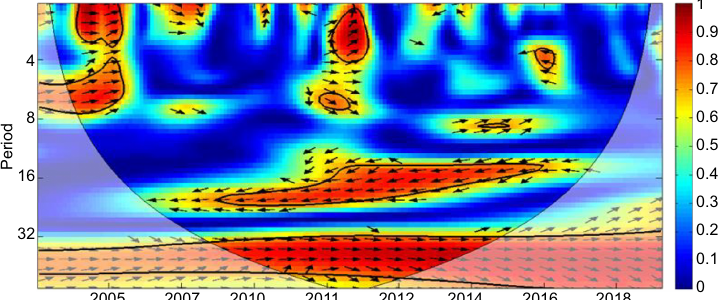
Figure 5. Comovement between Google search queries index and Tunindex